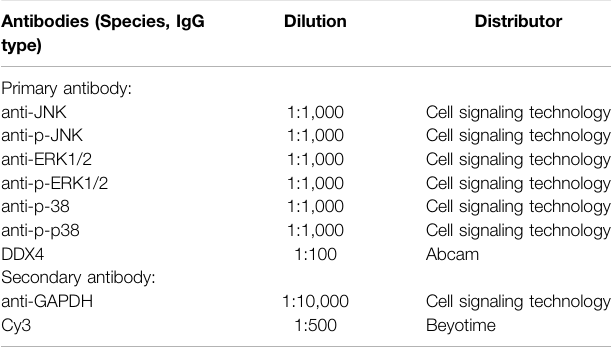
TABLE 2 | Primary and secondary antibodies used for Western blotting and Immuno fl uorescence. Antibodies (Species, IgG